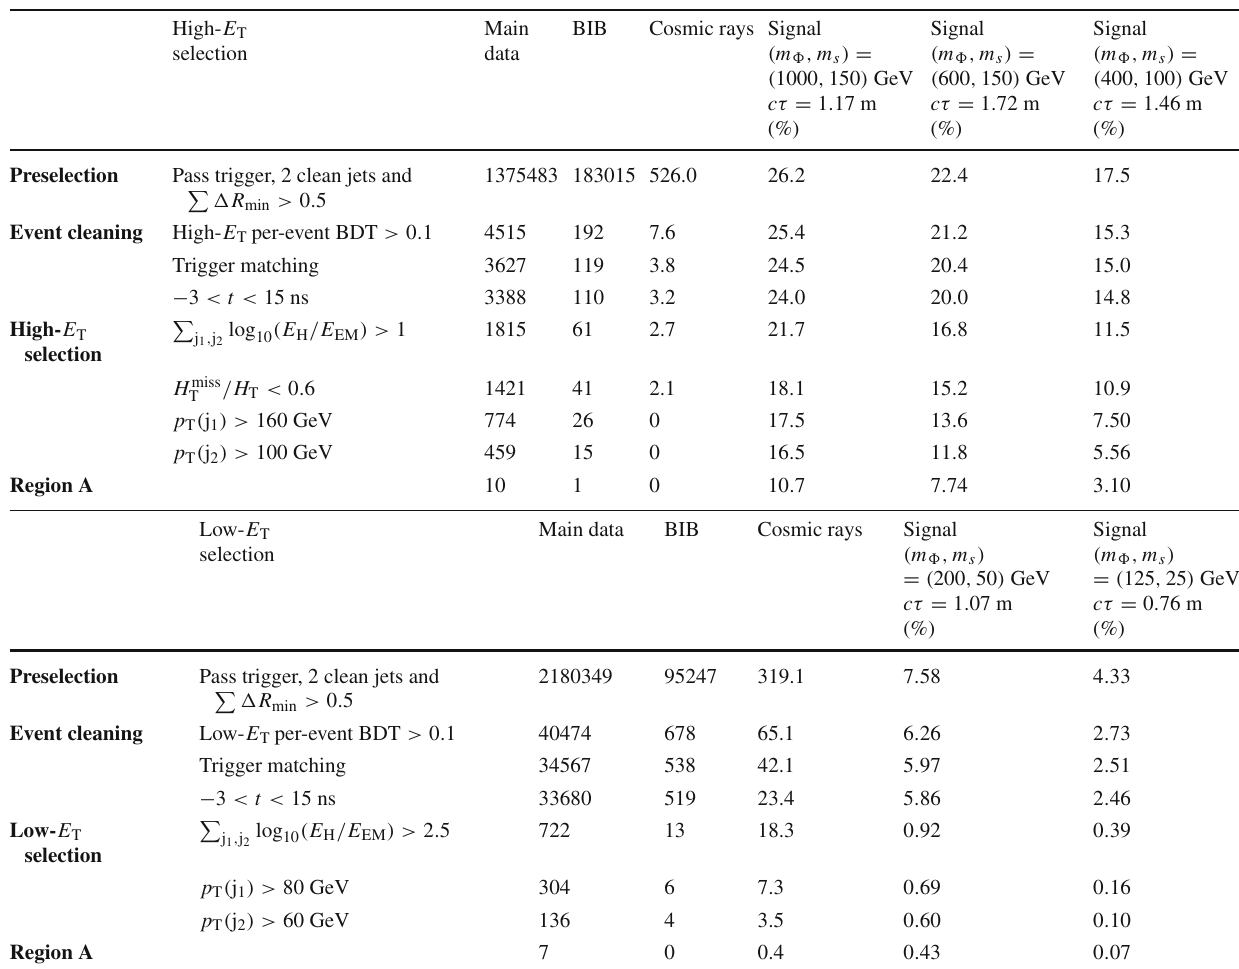
Table1 Sequentialimpactofeachrequirementonthenumberofevents passing the selection for the high- E T (top) and low- E T (bottom) anal- yses. The quoted number for BIB corresponds to the number of events in the BIB dataset passing the selection. The number of events for the cosmic rays is estimated from the cosmic-ray dataset by applying cor-